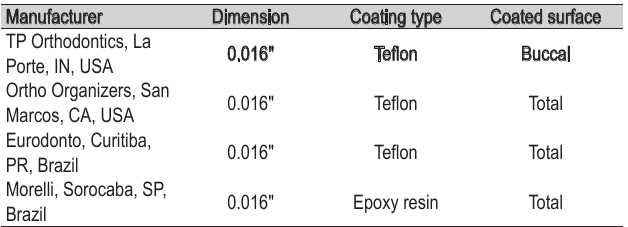
Table 1 - Characteristics of the nickel–titanium aesthetic archwires and respective control